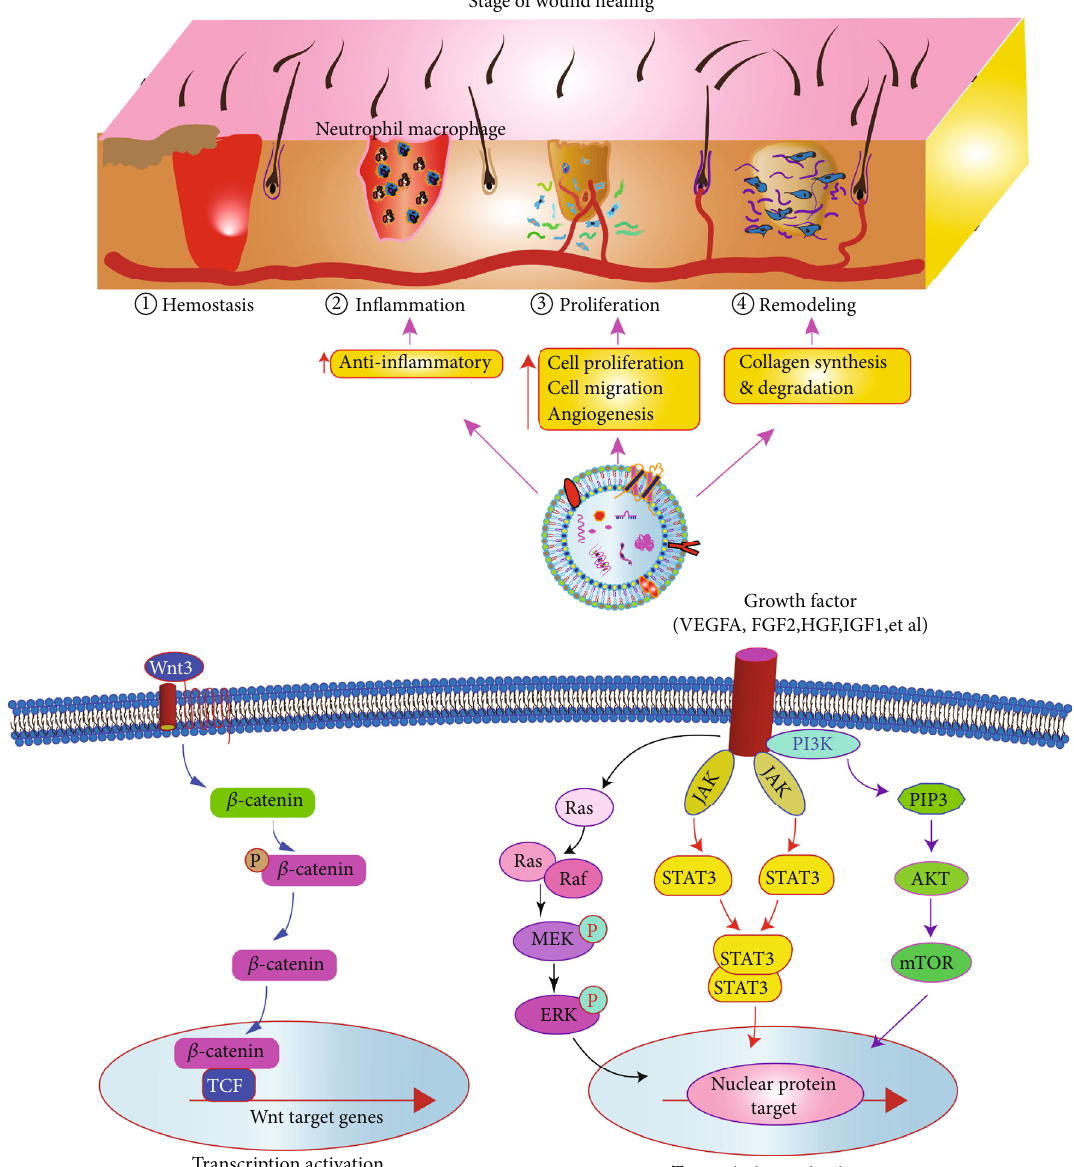
Figure 5: CDNs promote wound healing by enhancing angiogenesis, reducing in fl ammation, increasing cell proliferation and migration, and restoring tissue integrity. The contribution of signaling pathways in which the exosome can activate the Wnt3/catenin, PI3K/Akt, JAK/STAT3, Ras/ERK signaling pathways to further accelerate wound